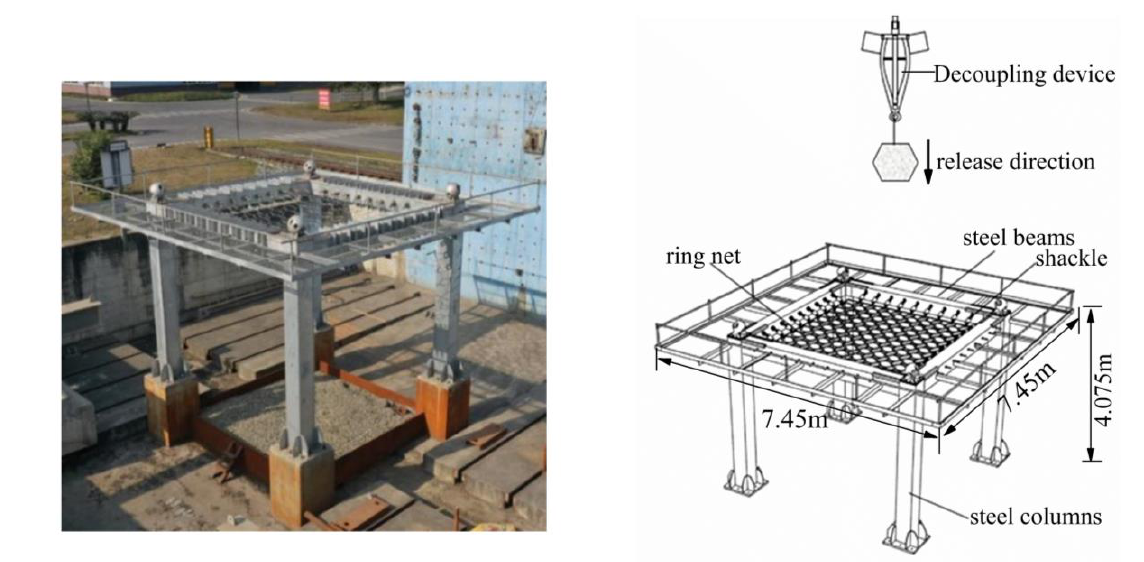
Figure 6. Dynamic impact test device. Table 3. Test cases.